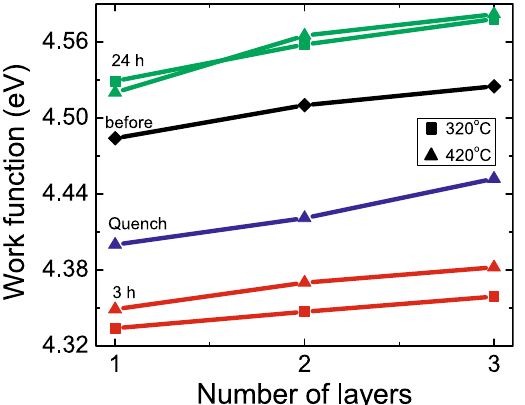
Figure 4. Evolution of the work function of MoS 2 film φ before and after annealing for mono-, two-, and MoS 2 three-layer films. The annealing was performed at 320 °C ( □ ) and 420 °C ( Δ ) and measured 3 hours and 24 hours after reaching the room temperature. The blue Δ show the values of the work function when the sample was rapidly quenched from 420 °C to room T using liquid nitrogen. The values are compared to equilibrium values of the work function at room temperature (black